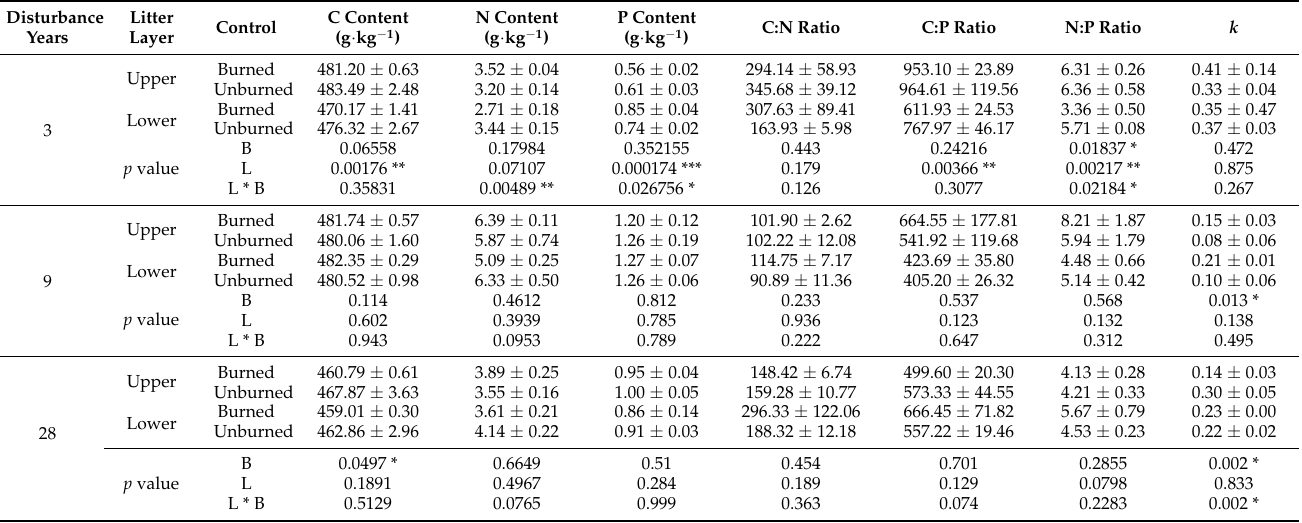
Table A1. Stoichiometry and two-way ANOVA of C, N and P in different layers of litter under the same burning age.